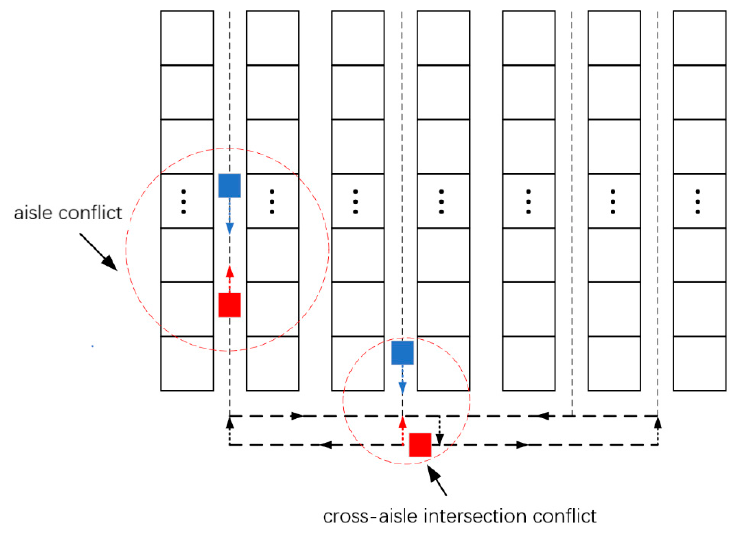
Figure 2. Schematic of the congestion.